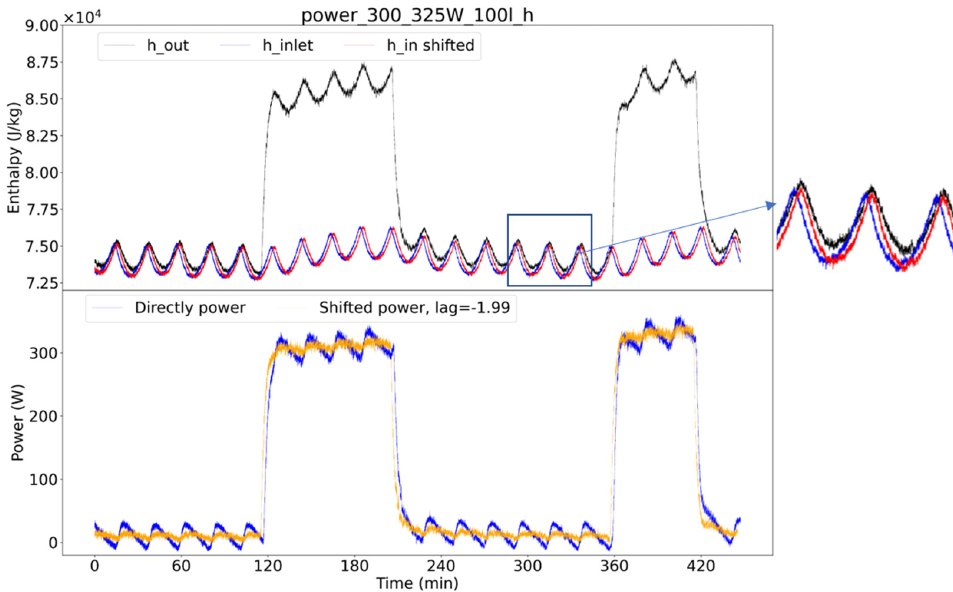
Figure 12. Comparison of the enthalpy and calorimetric evaluation of the power with 300 and 325 W: enthalpy-the red curves indicate the enthalpy calculated at the time earlier than time t with time lag dt; power-the orange curves indicate the power calculated with Equation (2); for comparison, the blue curves show the power calculated without accounting for the time delay.